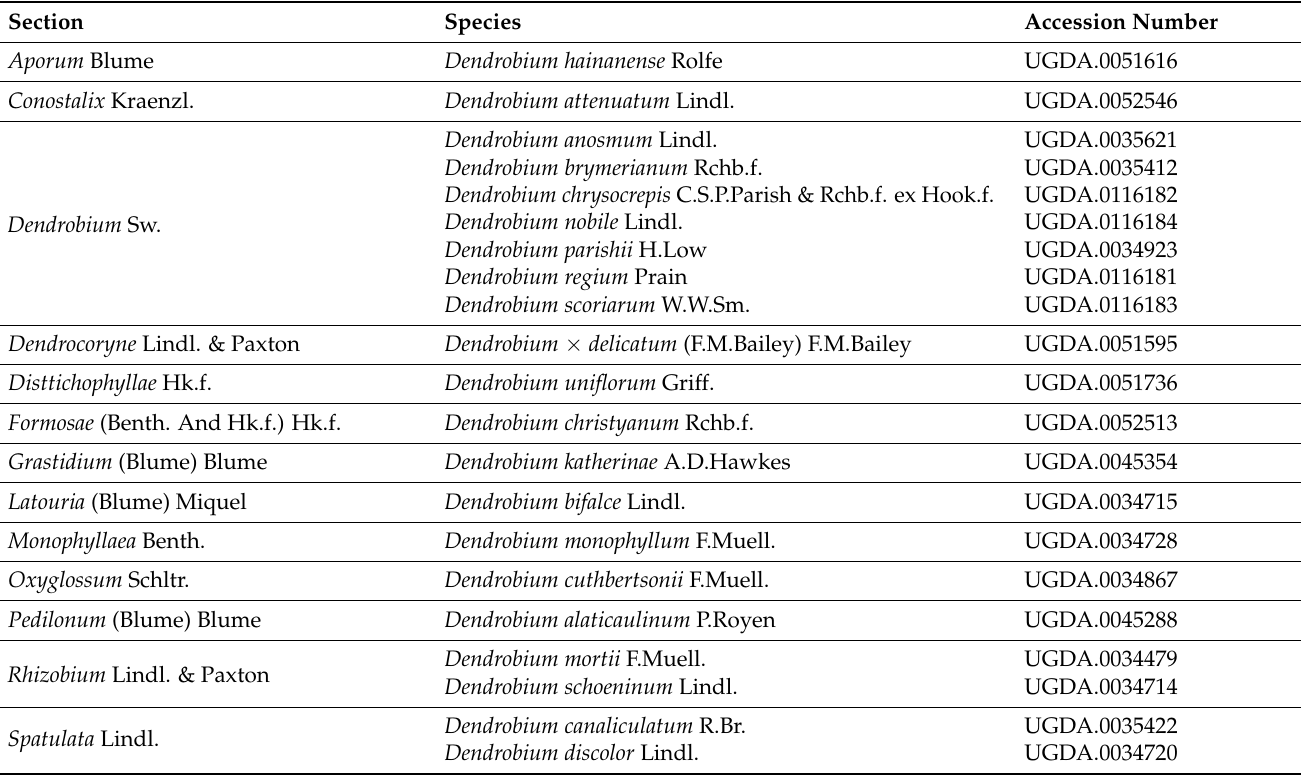
Table 3. List of species of Dendrobium used in this study (classification of the taxa follows the Wood systematic